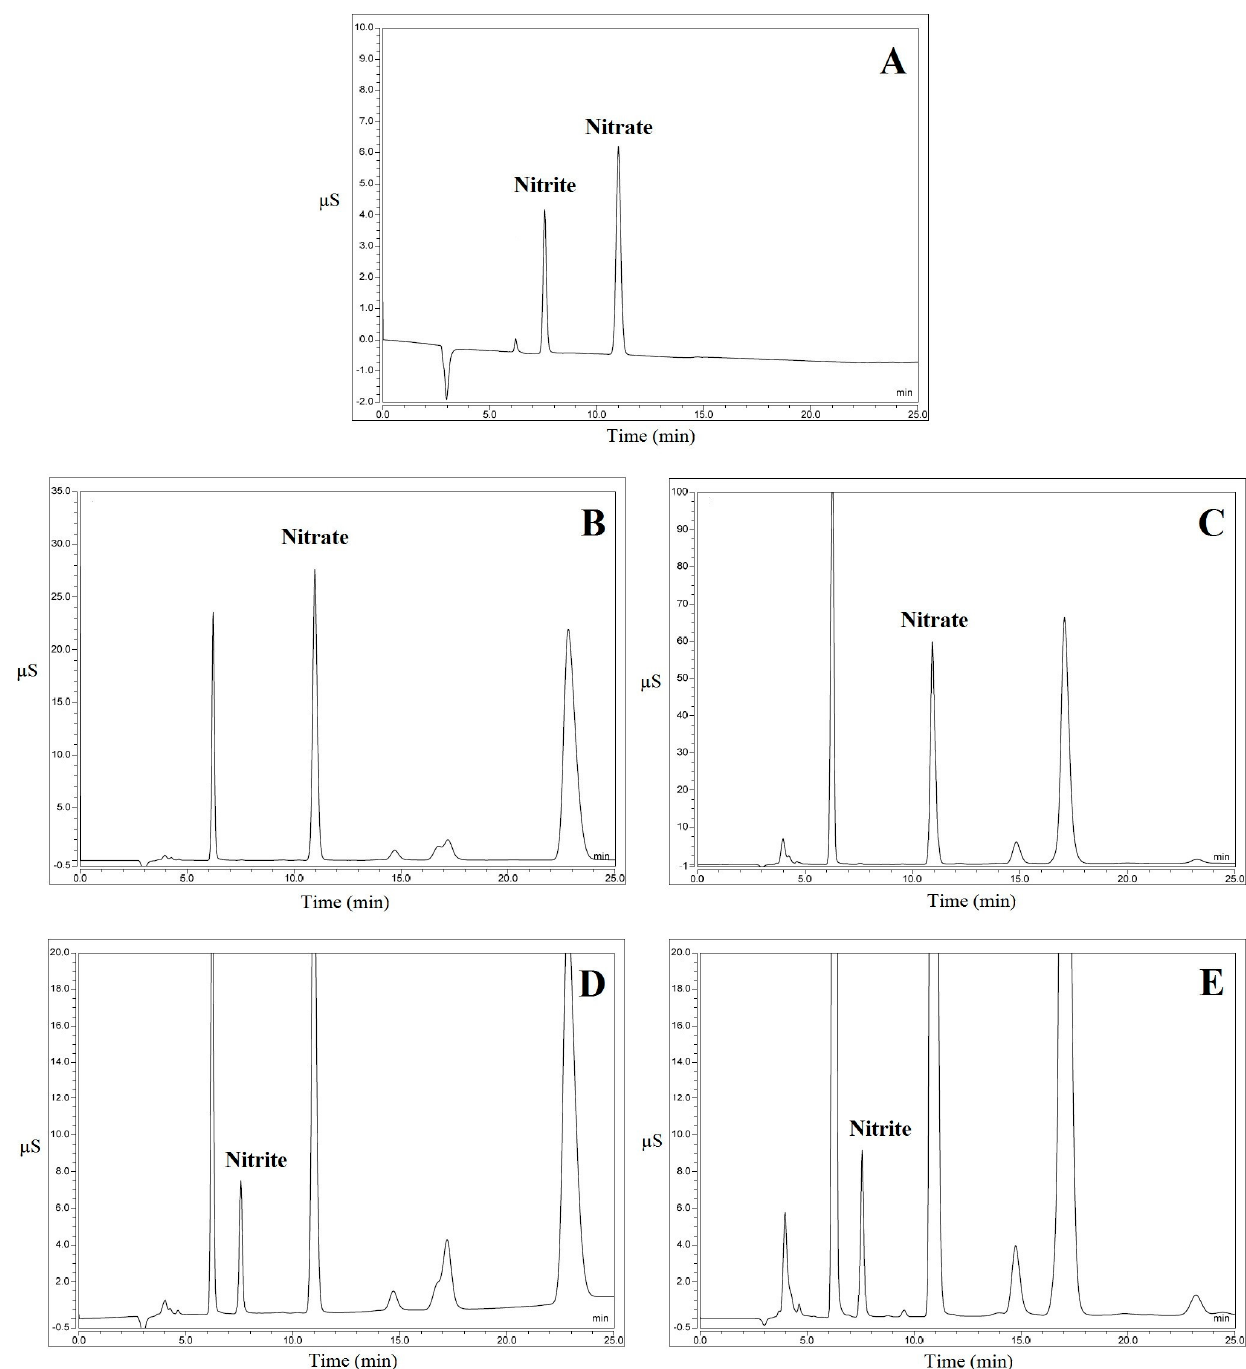
Figure 2. Chromatogram examples of HPIC analyses. ( A ): Nitrite and nitrate standard solution; ( B ): Fresh-cut Swiss chard sample with nitrate concentration of 2838.8 mg kg − 1 ; ( C ): Fresh-cut wild rocket sample with nitrate concentration of 7012.9 mg kg − 1 ; ( D ): Fresh-cut Swiss chard sample with nitrite concentration of 131.6 mg kg − 1 ; ( E ): Fresh-cut wild rocket sample with nitrite concentration of 206.6 mg kg − 1